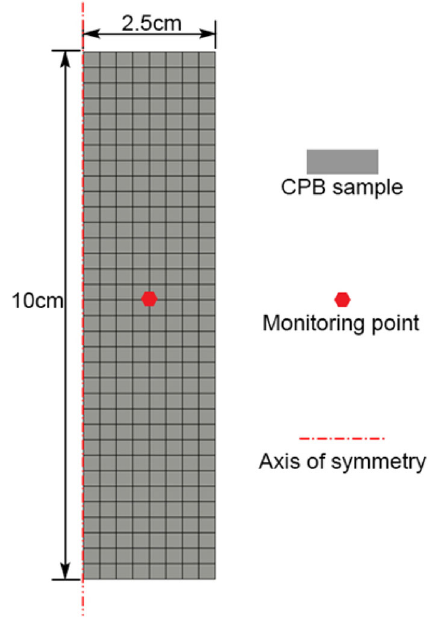
Fig. 10 Mesh and geometry of simulated CPB sample for Case Study 2.